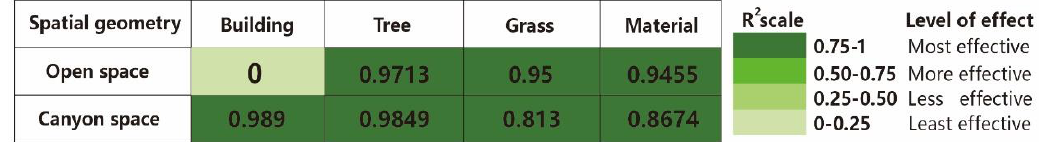
Figure 18. Correlation between thermal comfort and coverage ratio of different parameter in canyon space at 3:00 pm.